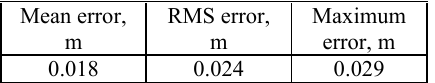
Table 6. Horizontal positional accuracy estimation of measuring obstruction clearance